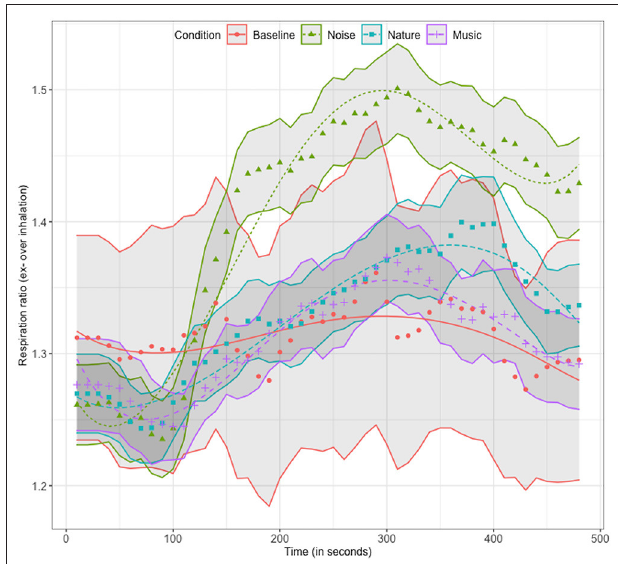
FIGURE 4 | Mean, standard error and model fitted curves for the respiration ratio timeseries for all